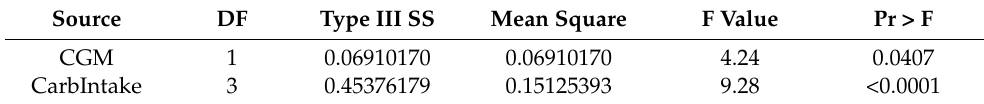
Table A3. Log A1C with CGM and CarbIntake as independent variables.